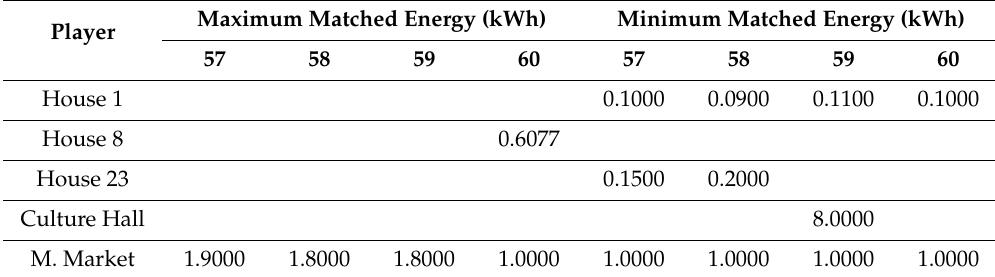
Table 5. Players’ period